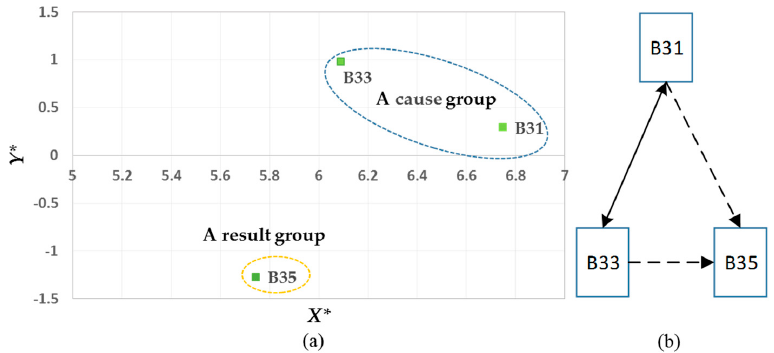
Figure 8. Cause and effect diagrams for the financial institution. ( a ) The causal attributes of corresponding sub-criteria and ( b ) significant interactions.